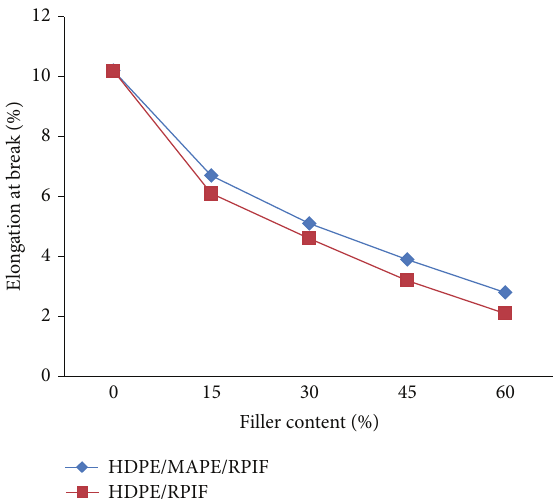
Figure 4: Water absorption at different RPIF